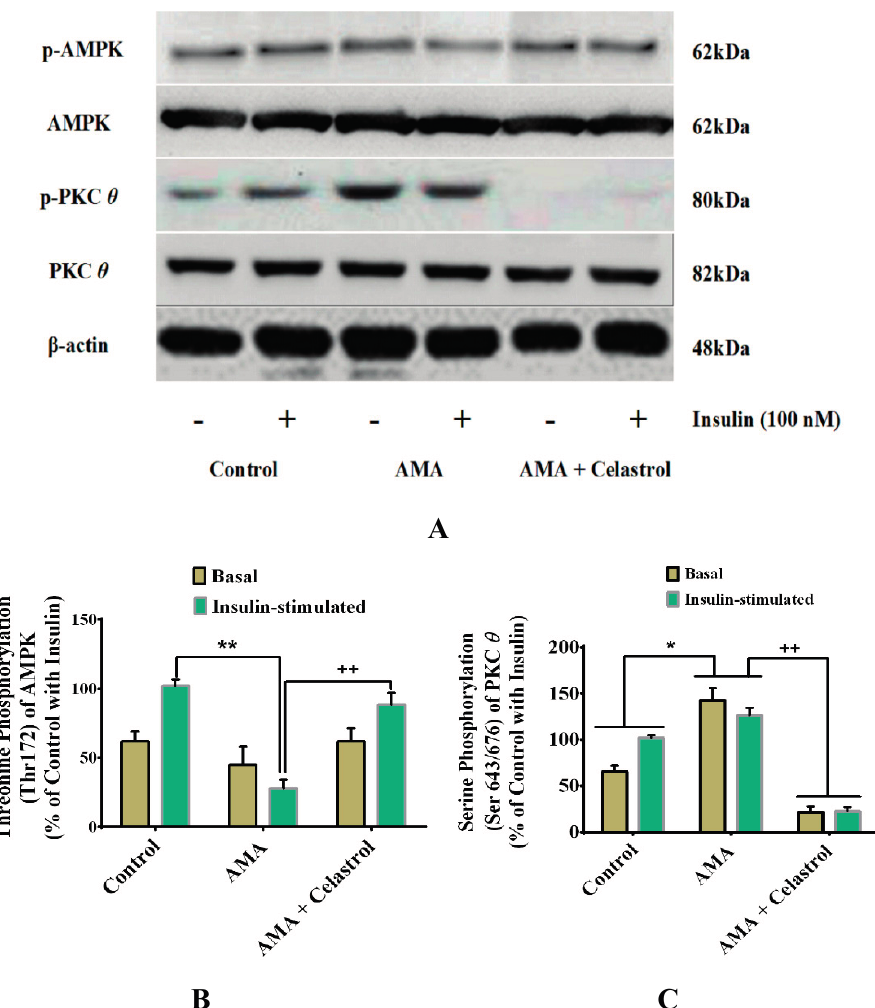
Figure 9. Effects of AMA and celastrol treatments on the protein expression of AMPK (Thr172) and PKC θ (Ser643/676) in human skeletal muscle-derived myoblast. Cells were cultured in media containing 30 µM AMA in the absence and presence of 15 nM celastrol for 48 h. Thereafter, cell lysates were subjected to western blot analysis ( A ). The percentage of specific and total protein phosphorylation was calculated to determine the relative level of exact amino acid residue phosphorylation ( A – C ). β -actin was used as internal protein loading control. Protein levels for each corresponding antibody obtained from densitometry were normalized to the β -actin signal. * p < 0.05 and ** p < 0.01 vs . untreated control; + p < 0.05 and ++ p < 0.01 vs . AMA-treated